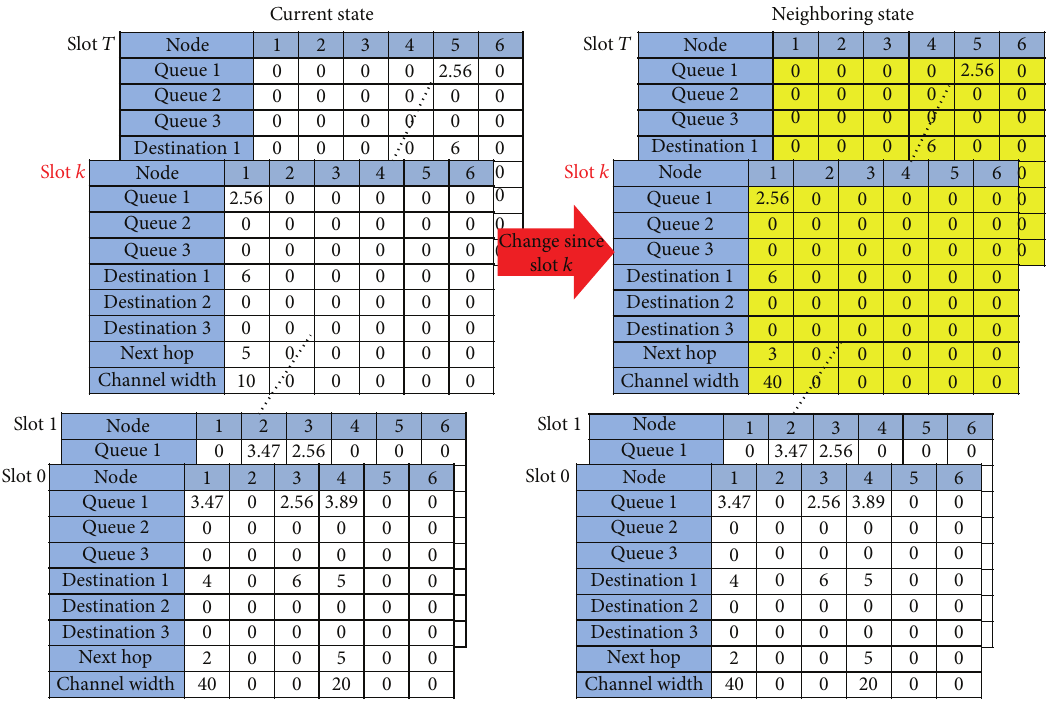
Figure 8: Illustration of neighborhood